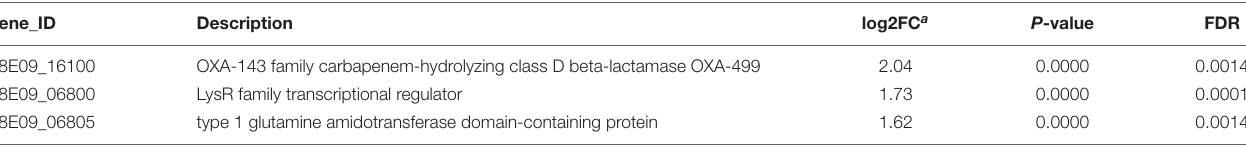
TABLE 4 | Differentially expressed genes in CAB010 compared with